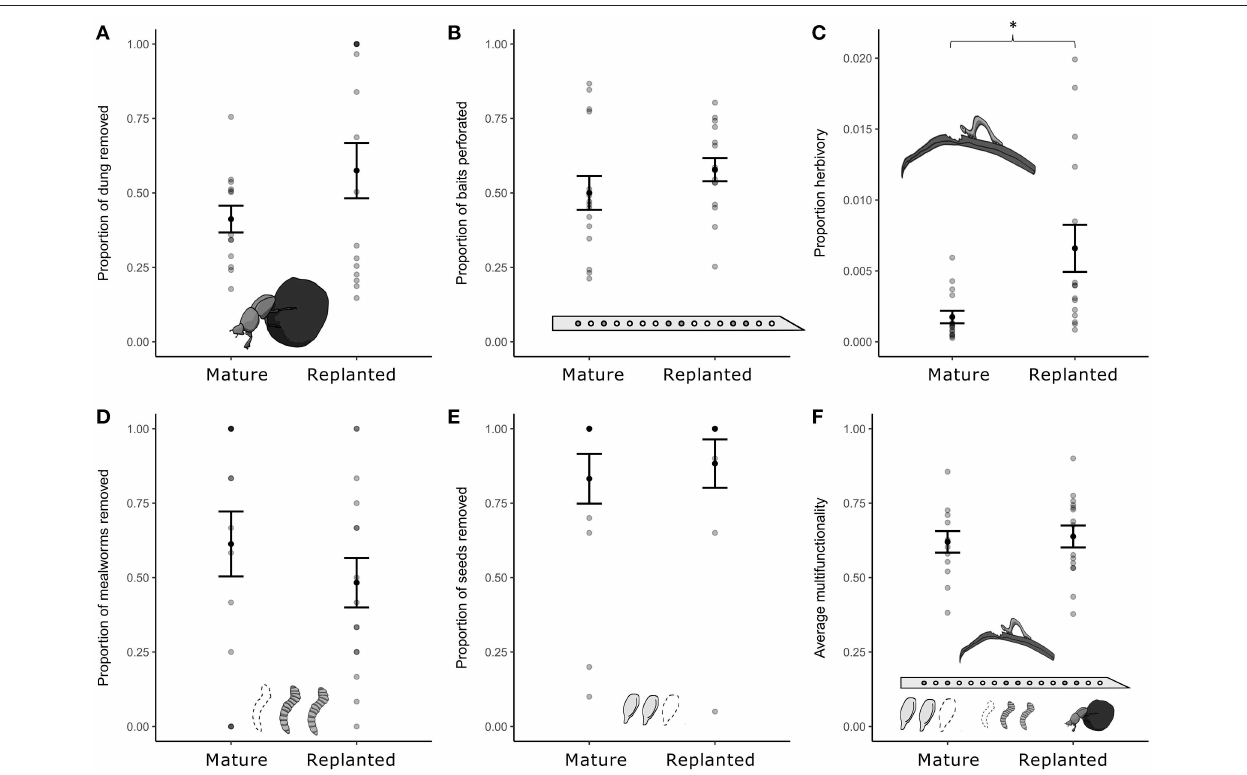
FIGURE 2 | The effect of oil palm replanting on (A) dung removal; (B) soil mesofauna feeding activity; (C) herbivory; (D) herbivore predation; (E) seed predation; and (F) average multifunctionality. Plots show mean ± SE. Mature denotes mature oil palm, and Replanted denotes replanted oil palm. Stars denote significant differences (* P < 0.05). Note the scale on the y-axis of plot (C) ranges from 0 to 0.020.